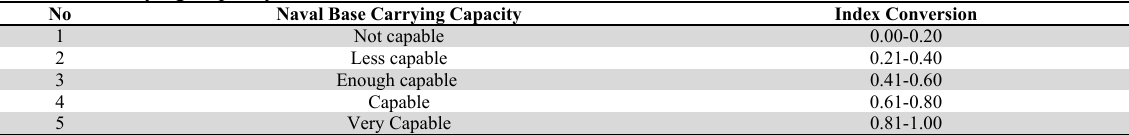
Naval Base Carrying Capacity